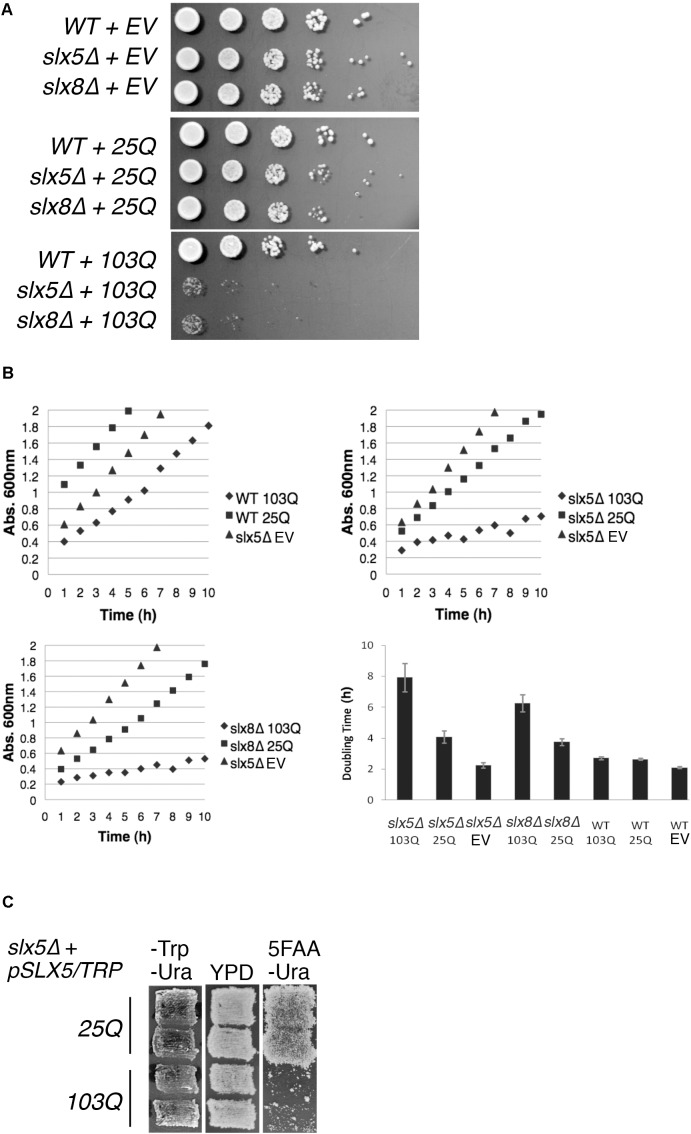
STUbL subunits Slx5 and Slx8 alleviate toxicity of poly-Q expanded Htt. (A) WT, slx5Δ, and slx8Δ strains expressing Htt-25Q, Htt-103Q, or empty vector (EV) were grown to mid-logarithmic phase and 5 μl of 10-fold serial dilutions of each culture were spotted on SC-URA medium. Plates were incubated at 30°C for 3 days. (B) Yeast transformants in A and the indicated controls were grown overnight in 5 ml of SC-URA medium. Ten OD600 readings of cultures were recorded every hour until the OD600 reached ∼2.0. The average doubling times of four independent experiments were graphed with +/− standard error. EV (empty vector) (C) A shuffle strain, slx5Δ with SLX5/TRP plasmid (YOK 2990), was transformed with either Htt-25Q or Htt-103Q constructs. Transformants were patched in duplicate on selective medium (SC-TRP URA) and rich medium (YPD). Patches were then replica plated on SC-URA medium with 5FAA to counter-select against the TRP1 marked plasmid.